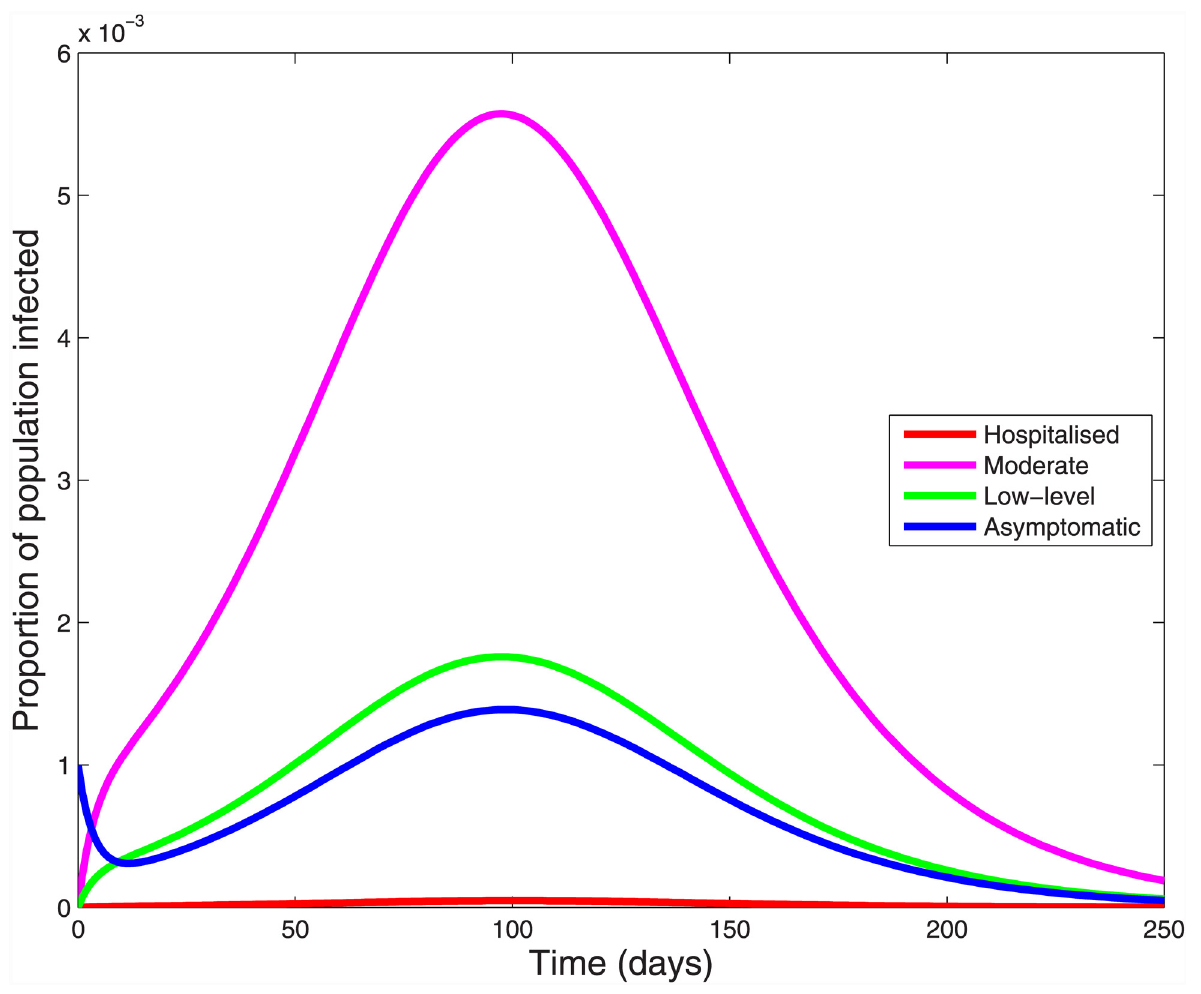
Fig 3. Incidence of influenza A(H1N1)pdm09 over time by infection